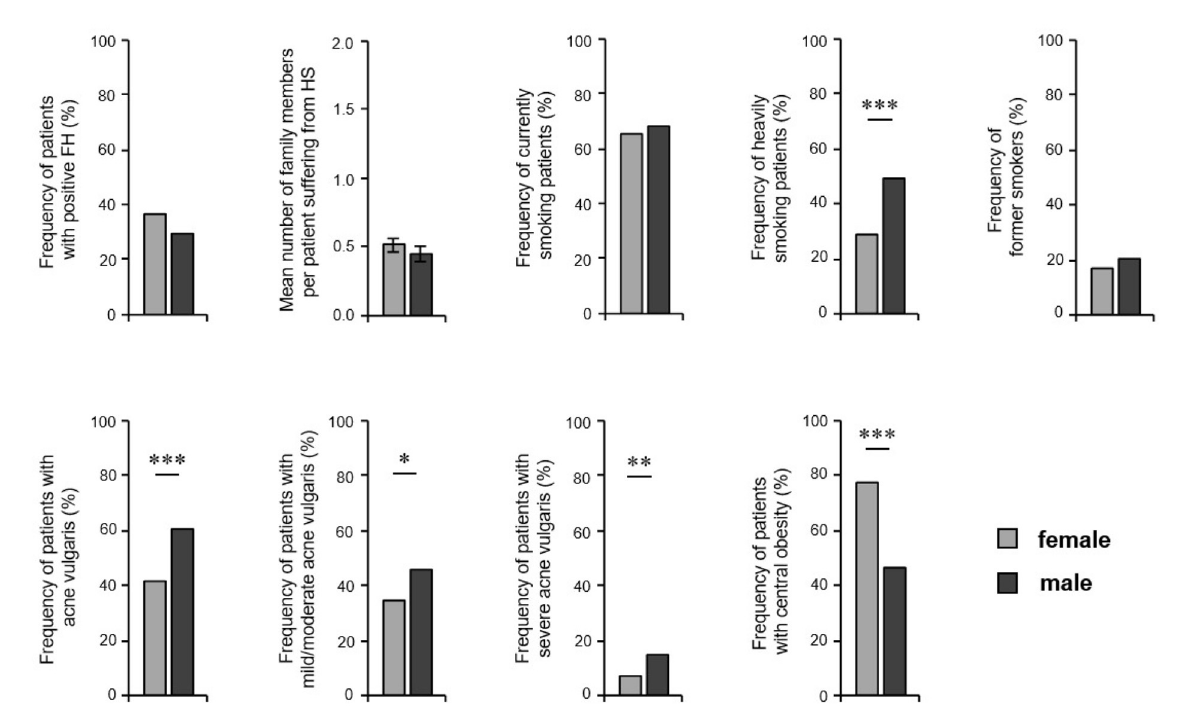
FIGURE1 Risk factors for the development of HS in both sexes. The frequency of HS patients with positive family history ( n = 473, female: 285, male: 188), the number of affected family members ( n = 472, female: 284, male: 188), the frequency of currently smoking patients ( n = 473, female: 284, male: 189) and those smoking an average number of cigarettes of > 20 per day ( n = 427, female: 261, male: 166), of former smokers ( n = 472, female: 284, male: 188), as well as the frequency of patients with concomitant acne vulgaris ( n = 442, female: 266, male: 176), and patients with central obesity ( n = 385, female: 238, male: 147) are given. Significance of differences was assessed by the Chi-square test (* P < 0.05, ** P ≤ 0.01, *** P ≤ 0.001).